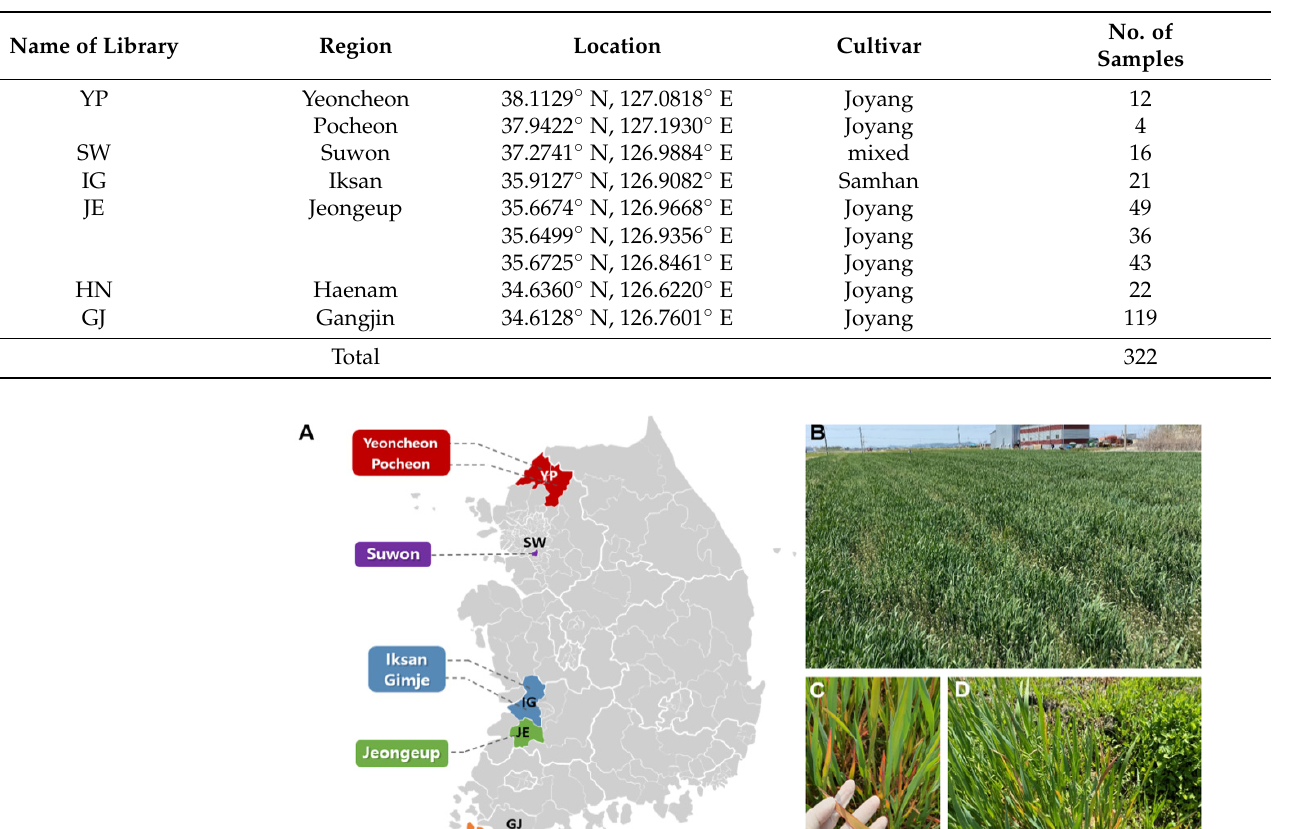
Table 1. Detailed information for name of library, sample location, and number of samples in each library.